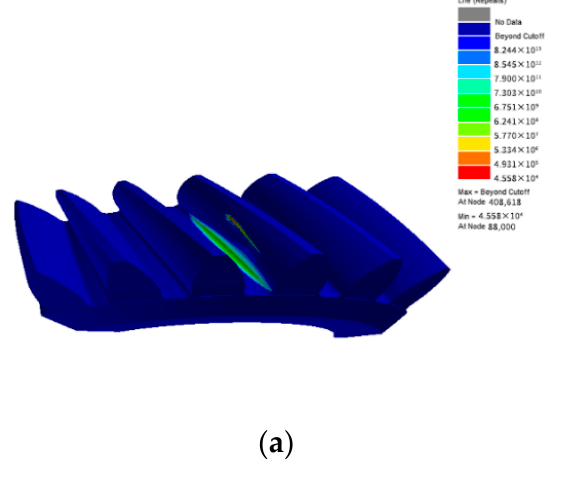
Figure 16. Fatigue life maps of pinion with four load spectrums. ( a ) With contact stress load spec- trum of electro-magnetic braking; ( b ) With contact stress load spectrum of friction braking; ( c ) With